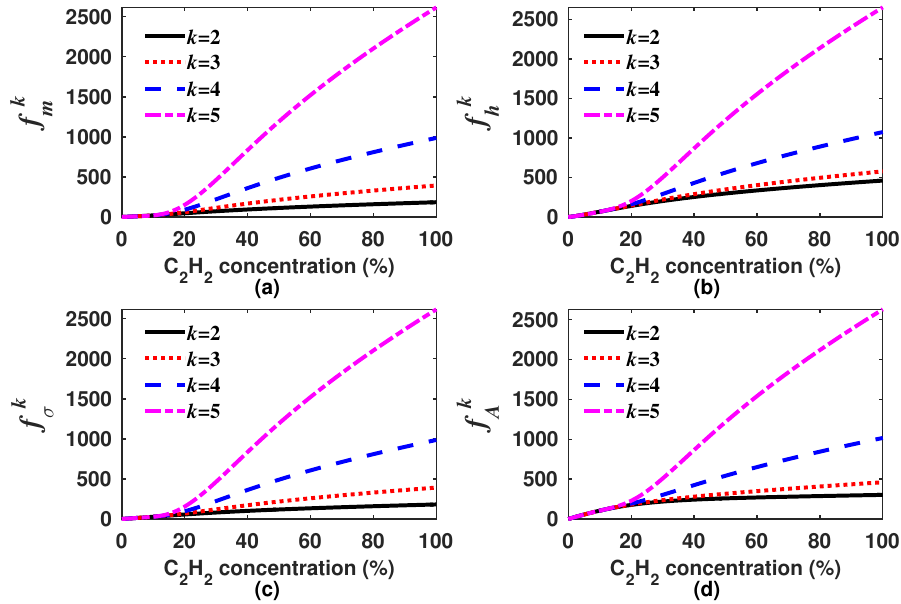
Figure 6. Generating functions ( a ) f k m ; ( b ) f k we considered k as 2, 3, 4 and